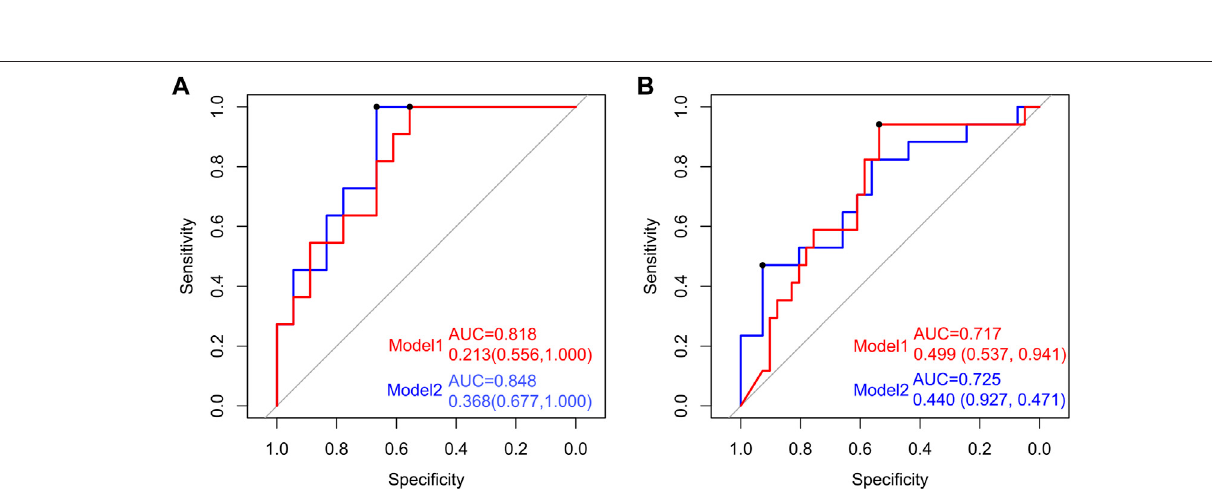
Frontiers in Cell and Developmental Biology |